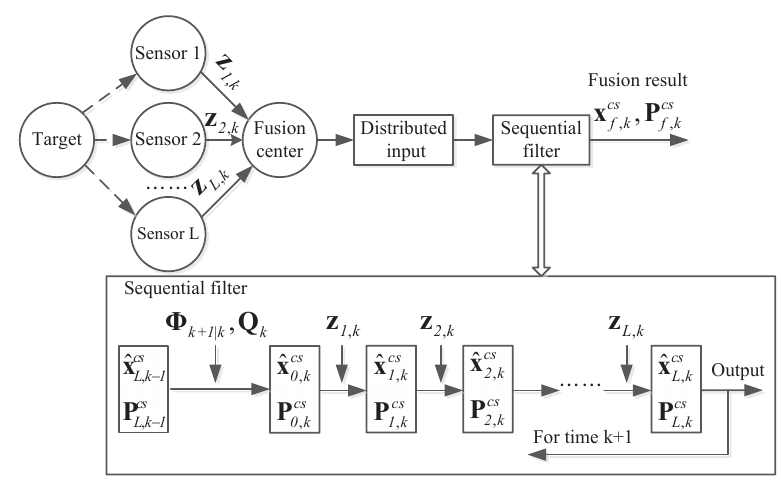
Figure 4. The structure of centralized multi-sensor sequential fusion